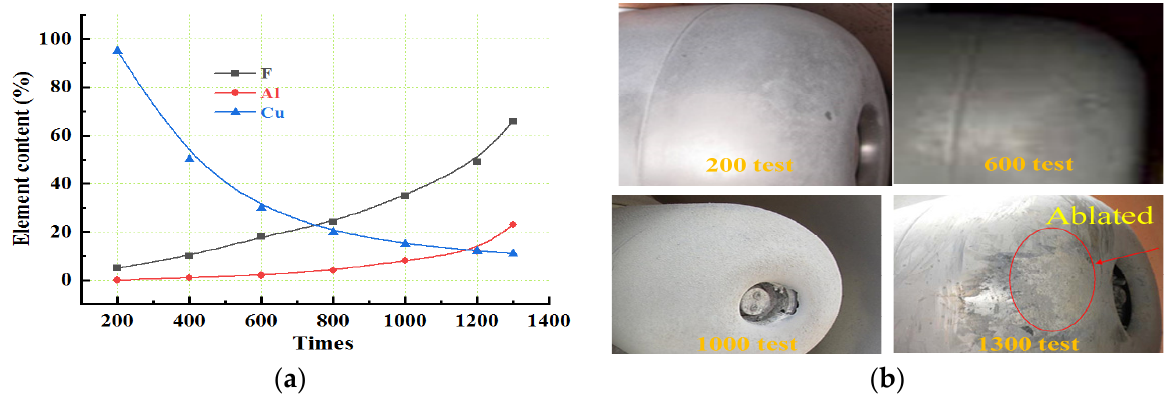
Figure 5. The element on test electrode’s surface. ( a ) is element changing of electrode surface with breaking tests ( b ) is surface morphology of the electrode.